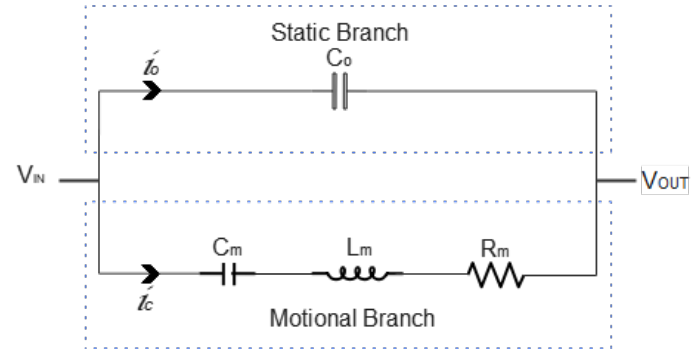
Figure 2. Lumped element for the Butterworth–Van Dyke